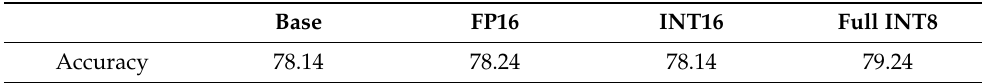
Table 1. The accuracies of the models obtained by post-training quantization.